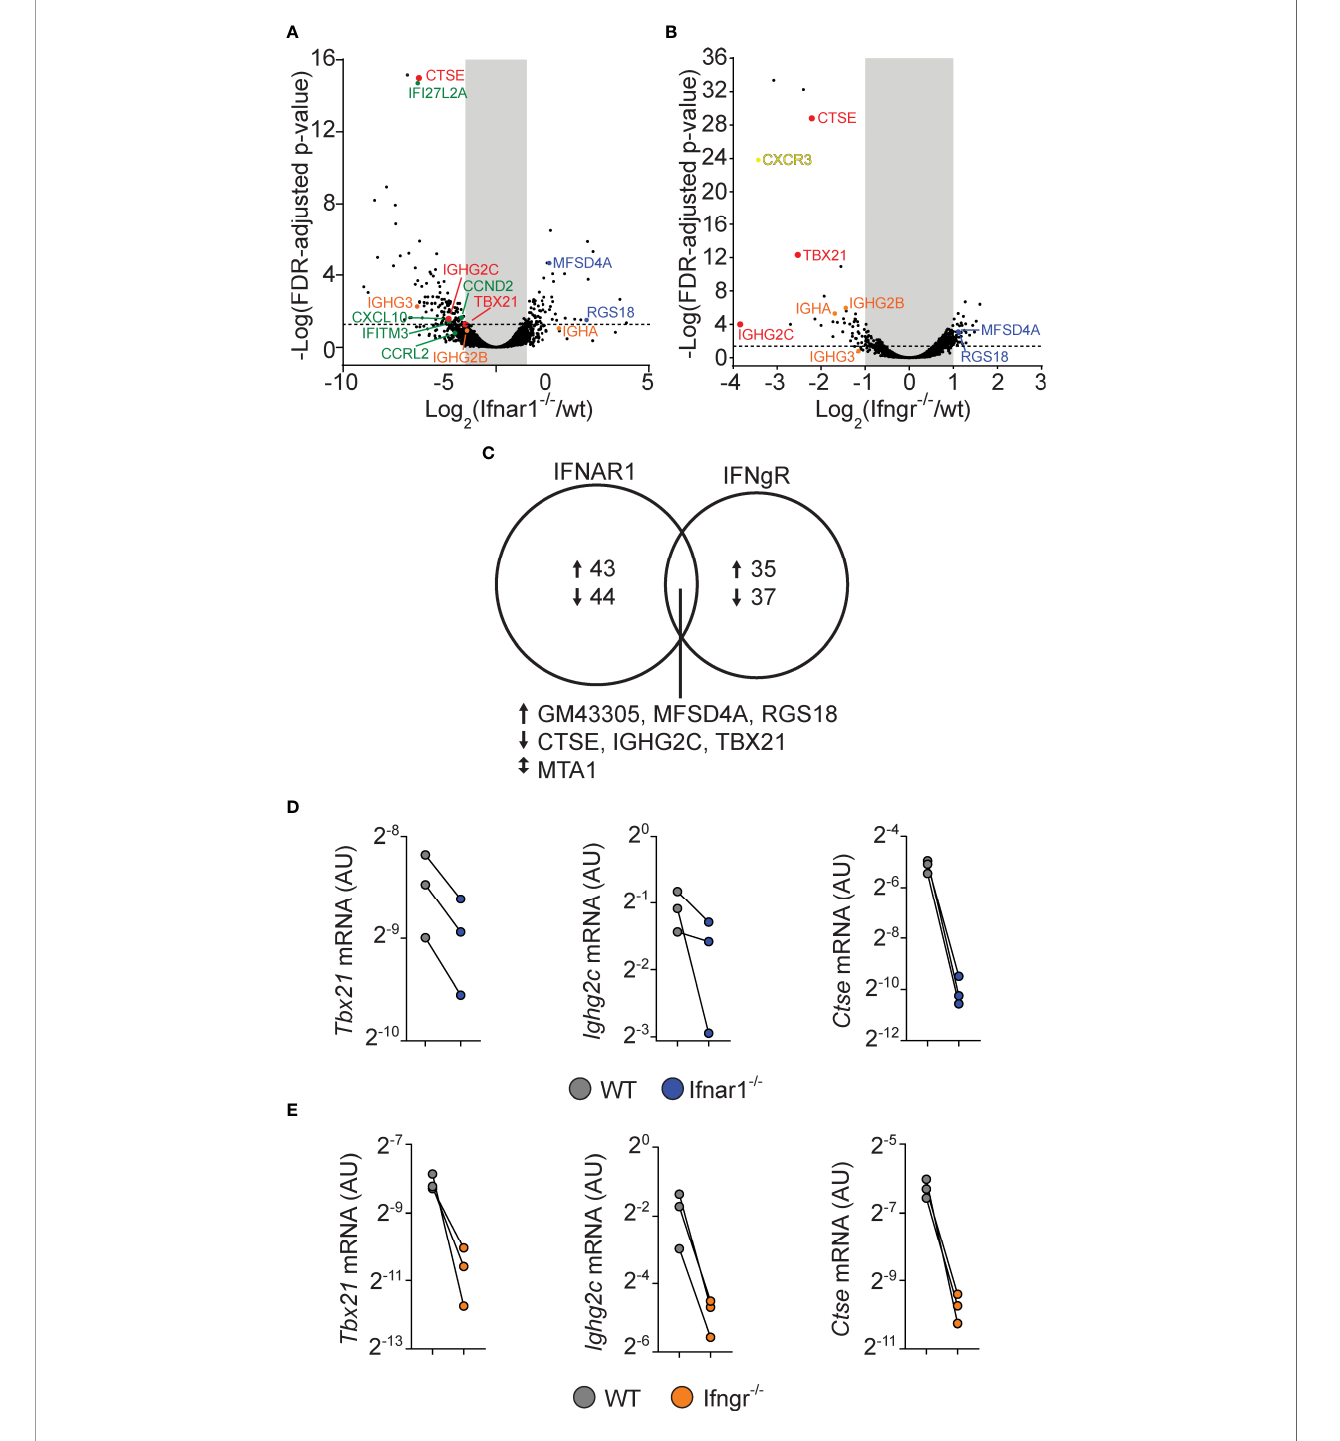
FIGURE 6 | B cell intrinsic type I and type II signaling confers largely non-overlapping gene expression programs in GC B cells but co-regulate enhanced Tbx21 and Ighg2c expression. WT and gene-targeted GC B cells were separately sorted from the WT : Ifngr1 - /- and WT: Ifnar1 -/- mixed BM chimeras described in fi gures 3 and 5, respectively, and processed gene expression analysis. (A – C) mRNA sequencing results. (A, B) Volcano plots of changes in gene expression between WT and Ifnar1 -/- (A) or Ifngr1 -/- (B) GC B cells. (C) Venn diagram showing all genes with >2-fold change and FDR < 0.05 when comparing WT and Ifnar1 -/- or Ifngr1 - /- GC B cells. The genes regulated by both type I and type II IFN signaling in GC B cells are listed below the diagram. (D, E) Quantitative rt-PCR analysis of gene expression in Ifnar1 -/- (D) and Ifngr1 - /- (E) GC B cells of genes identi fi ed by mRNA sequencing to rely on both type I and type II IFN B cell intrinsic signaling. Results are from three individual